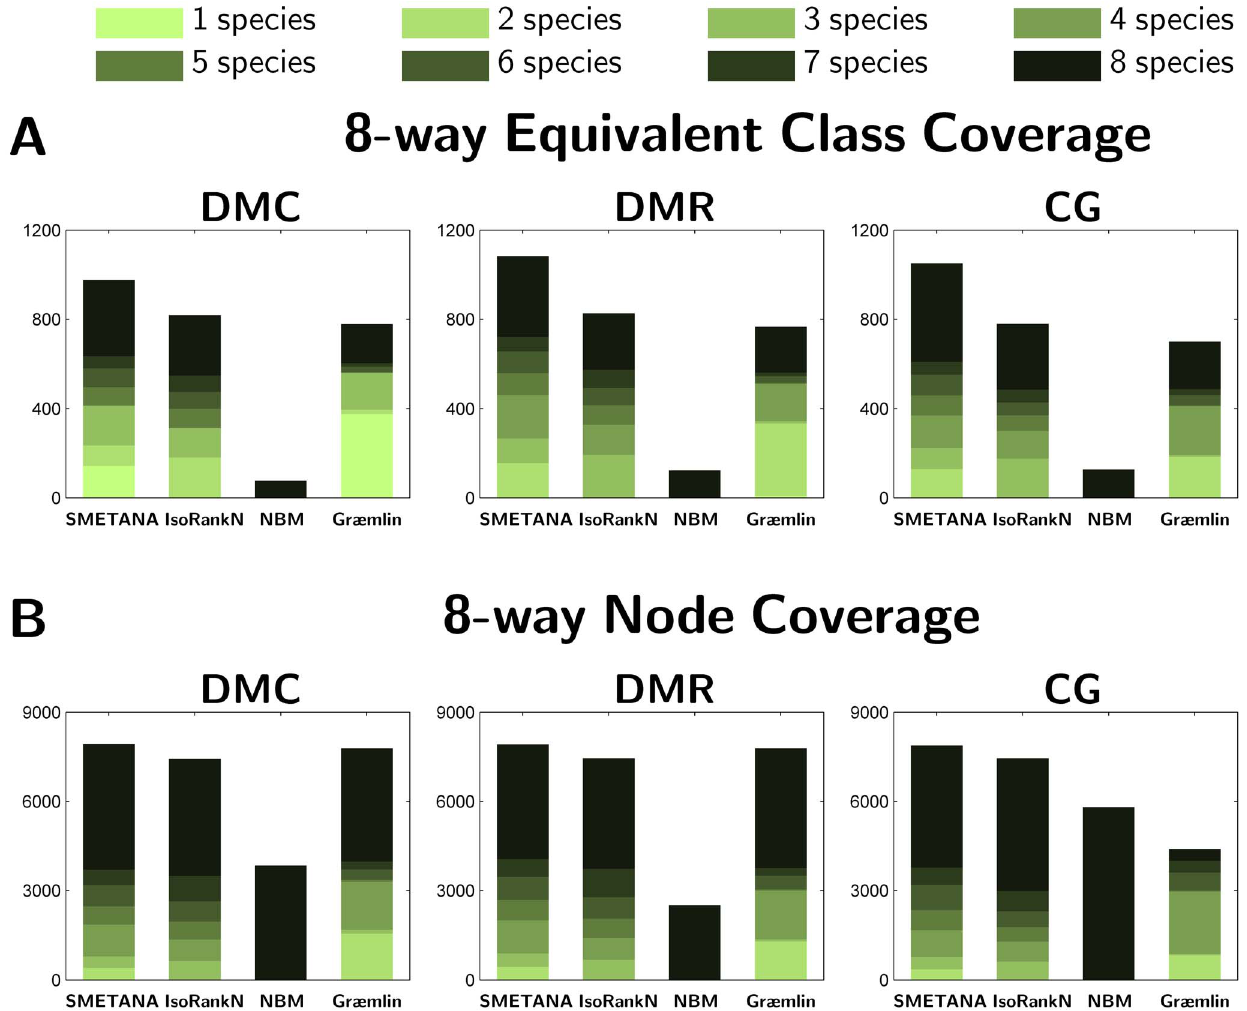
Figure 2. Performance of various network alignment algorithms. (A) Equivalence class coverage: Number of equivalence classes in the 8-way alignment experiment that contain nodes from k species ( 1 ƒ k ƒ 8 ). (B) Node Coverage: Number of nodes (i.e. proteins) that belong to equivalence classes that contain nodes from k species in the 8-way alignment.